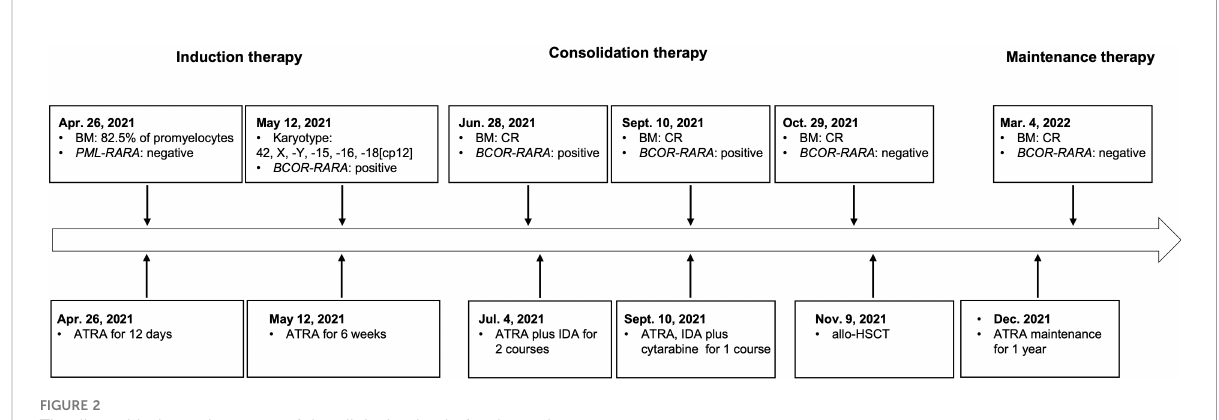
FIGURE 2 Timeline with the main events of the clinical episode for the